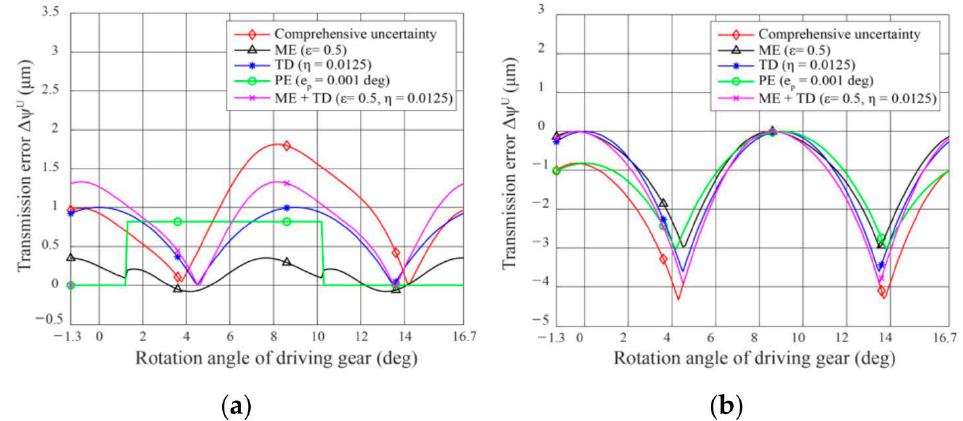
Figure 19. Transmission error of plastic spur gear pair under ( a ) unloaded and ( b ) loaded conditions (Comprehensive uncertainty: (cid:101) = 0.5, η = 0.0125, e p = 0.001 deg, ME : (cid:101) = 0.5, η = 0, e p = 0 deg, TD : (cid:101) = 0, η = 0.0125, e p = 0 deg, PE : (cid:101) = 0, η = 0, e p = 0.001 deg, ME + TD : (cid:101) = 0.5, η = 0.0125, e p = 0 deg).